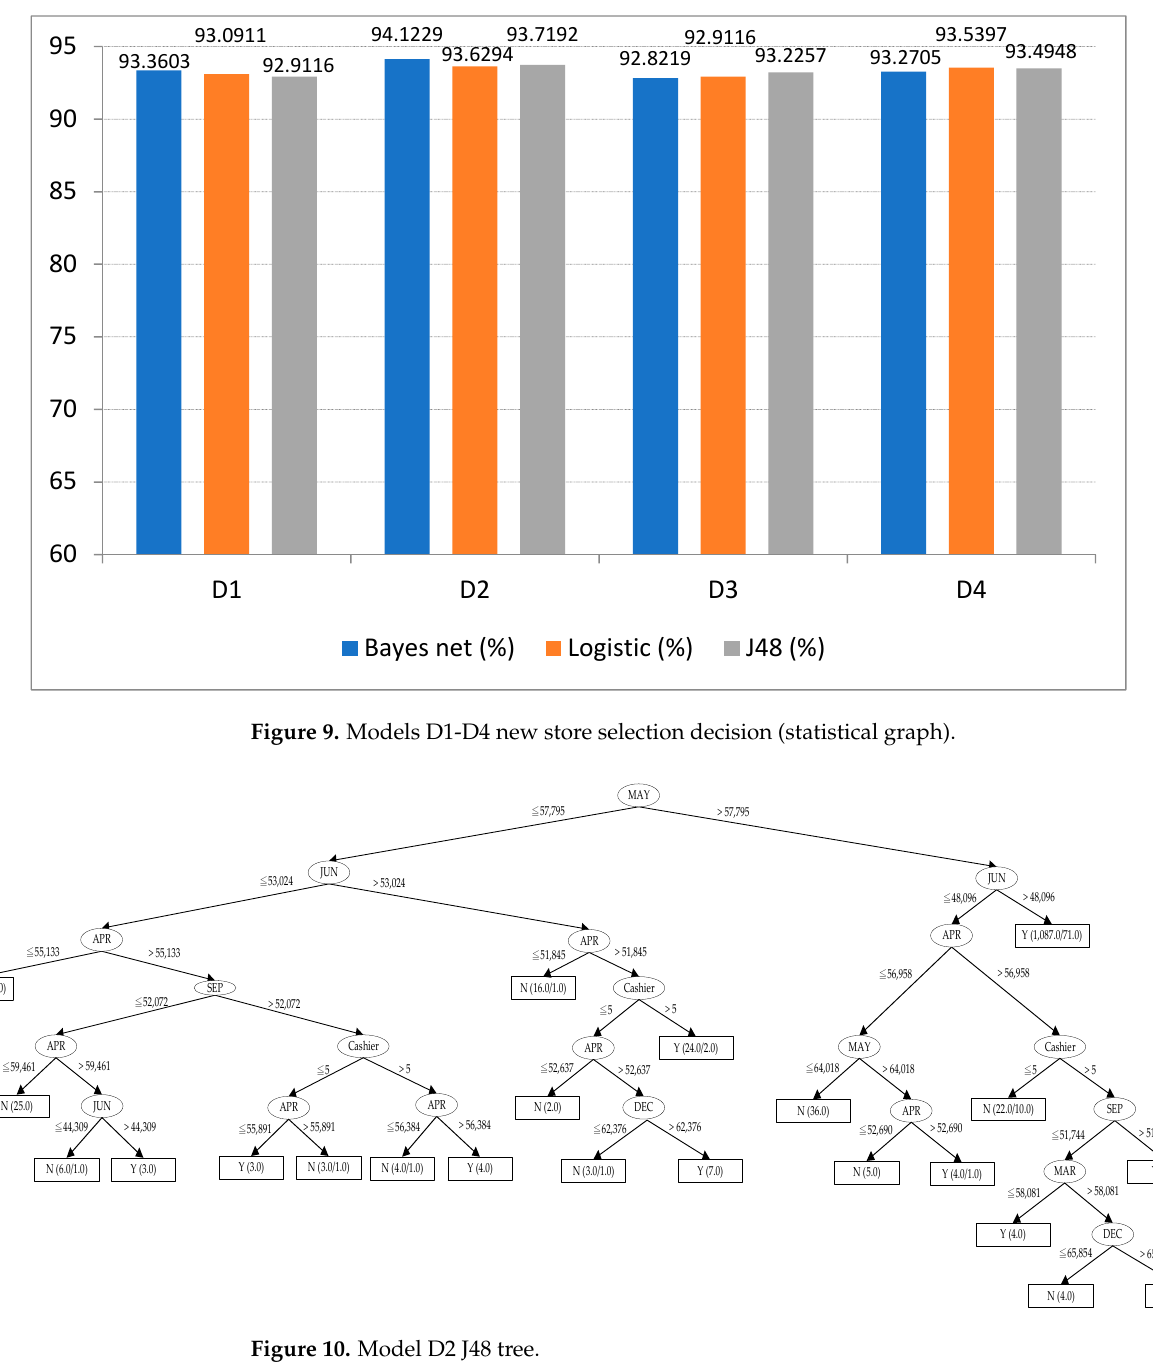
Figure 10. Model D2 J48 tree.